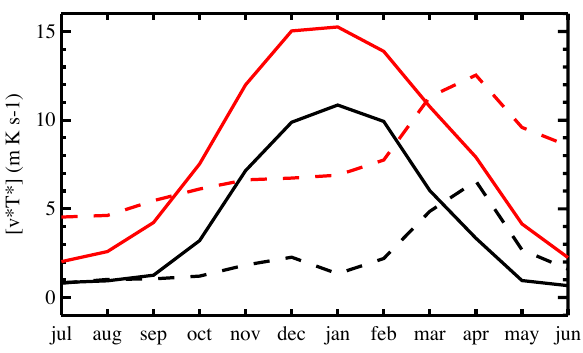
Fig. 4. ERA-interim climatological 100hPa heat flux, derived from monthly mean data ( [ v ∗ T , with an overbar representing the time mean, black) and monthly means of the heat flux derived from daily data ( [ v ∗ T ∗ ] , red), for the NH (solid) and minus the SH (dashed). Months noted on the horizontal axis are for the NH, and the SH values are shifted by 6 months compared to this axis.